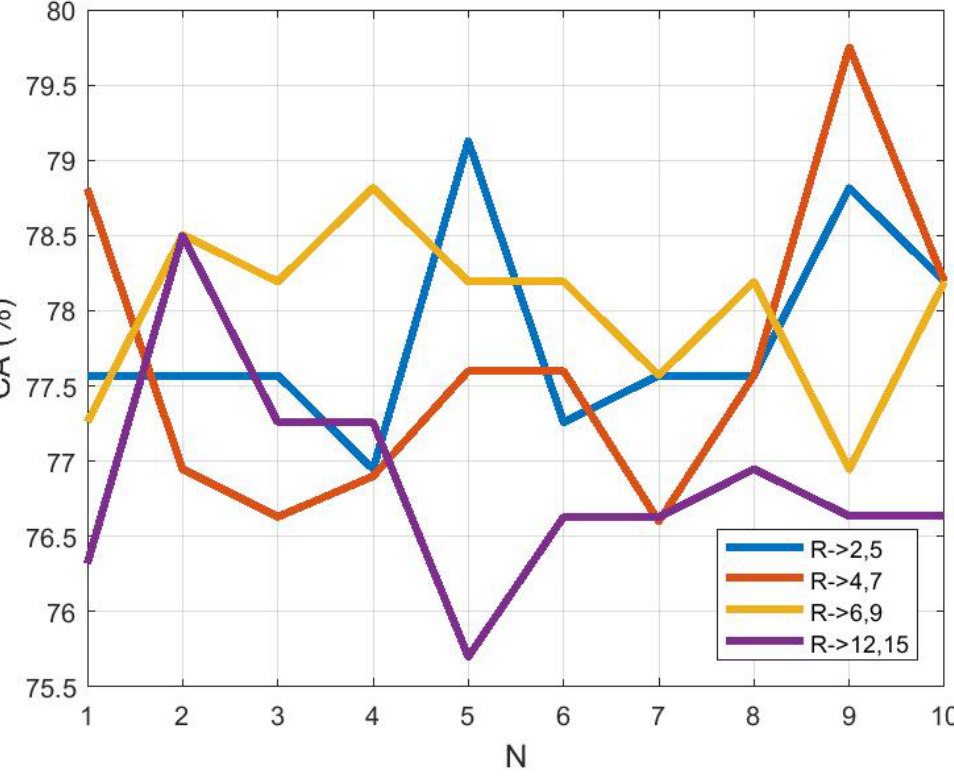
Figure 7. Classification accuracy as a function of descriptor size (N indicates a distinct